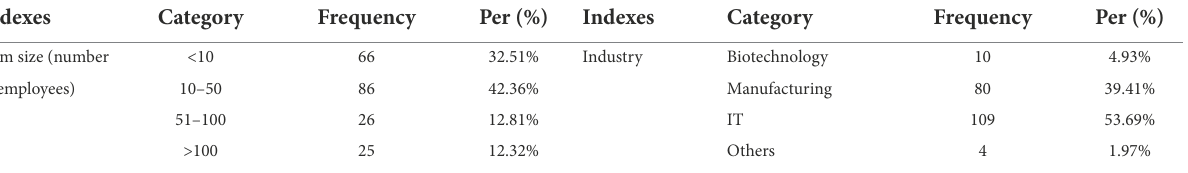
TABLE 1 Descriptive statistics for samples ( N =